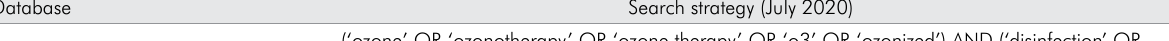
Table 1. Strategies for database